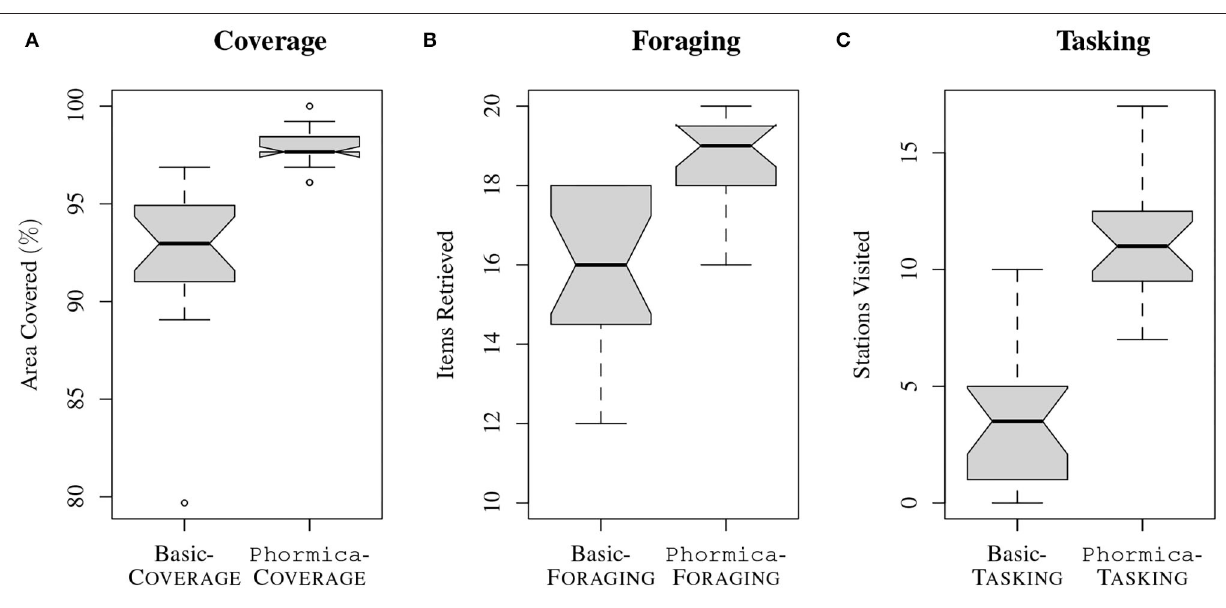
Therefore, many parts of the arena remain unexplored: the robots waste time re-exploring the already visited